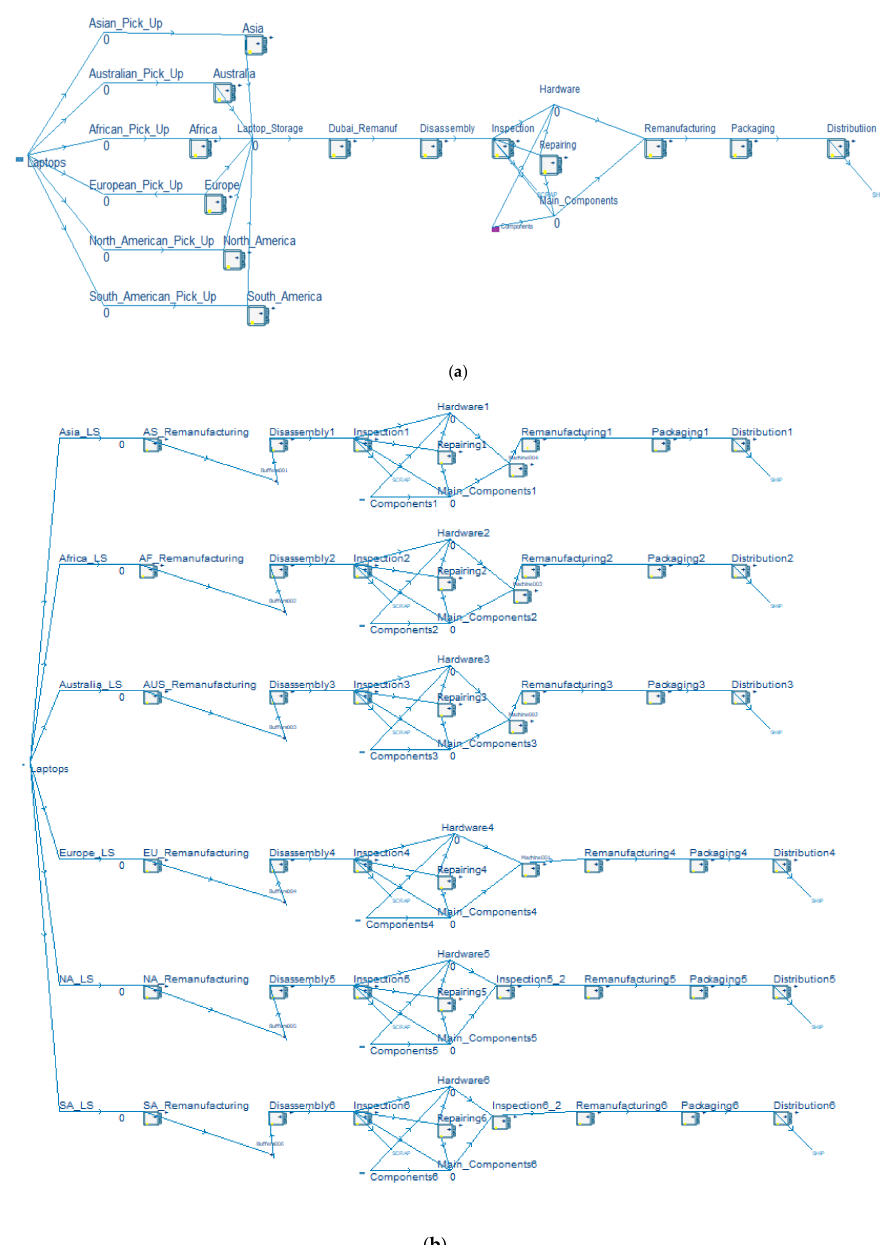
Figure 6. Simulation model in WITNESS Horizon for ( a ) centralized remanufacturing network; ( b ) decentralized remanufacturing